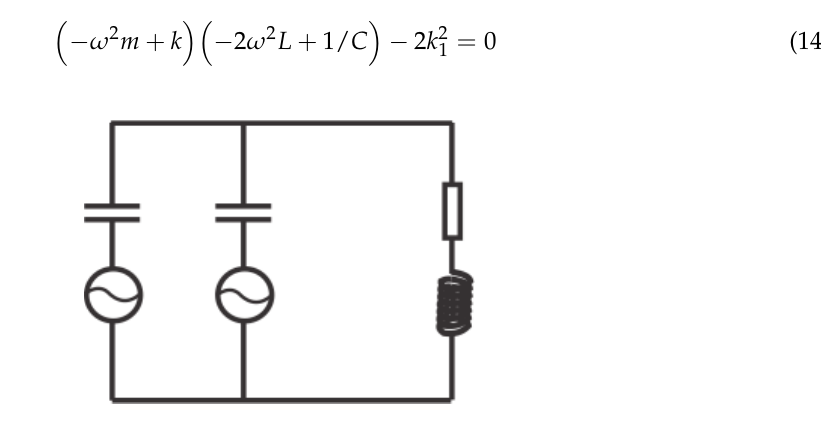
Figure 2. Equivalent circuit model of a unit-cell.